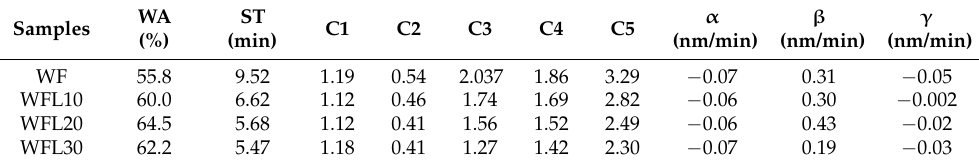
Table 9. The primary parameters of the lupin flour composites.